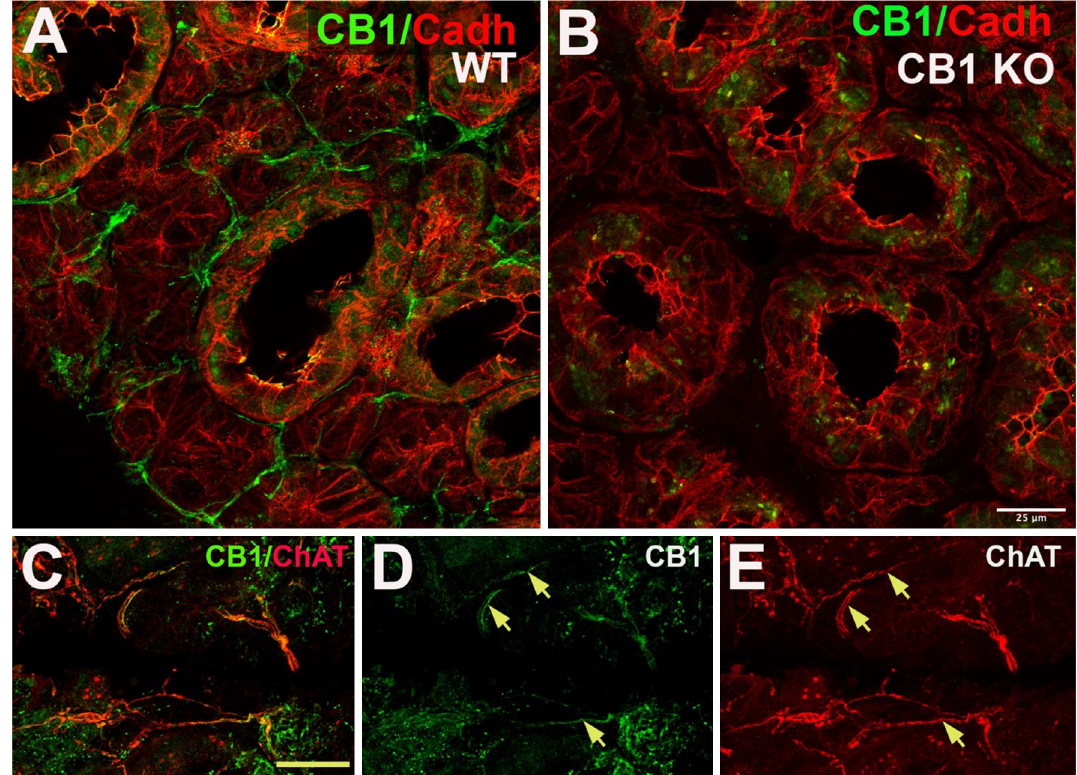
Figure 2. CB1 protein is expressed in a subset of cholinergic axons in submandibular gland. ( A , B ) Left panel shows CB1 (green) and cadherin (red) in wild type (WT) mouse submandibular gland. Right panel shows that CB1 staining in axon-like processes is absent submandibular gland from CB1 knockout mouse. ( C ) Double staining in submandibular gland of the mouse shows expression of CB1 (green) and choline acetyl transferase (ChAT, red), a marker for cholinergic axonal inputs. ( D , E ) CB1 (green) staining is seen in processes of ChAT- positive axons (arrows). Scale bar: ( A , B ) 25 µm; ( C – E ) 40 µm. Images processed using Adobe Photoshop vsn. 21.2 and FIJI (vsn 2.3.0/1.53q, available at https:// imagej. net/ Fiji/ downl to WT controls. Figure 3A, Control salivation volume (mm on phenol red thread ± SEM): 13.3 ± 0.7, n = 13; THC-treated: 4.7 ± 1.1, n = 11; ***p < 0.01, 1-way ANOVA with Dunnett’s post hoc vs. WT control), consistent with the reduced salivation seen in cannabis-exposed human subjects. Similarly, the potent CB1 receptor agonist CP55940 (0.5 mg/kg) also lowered saliva volume in WT (Fig. 3A; CP55940 (mm ± SEM): 6.9 ± 1.6, n = 13; 1-way ANOVA (F(4,58) = 11.0, p < 0.0001); Dunnett’s post hoc vs. WT control, **p < 0.01 for CP55940; ***p < 0.005 for THC, NS for SR141716). This was reversed by cotreatment with the CB1 receptor antagonist SR141716 (4 mg/ kg) (Fig. 3A, SR141716/THC (mm ± SEM): 12.5 ± 0.7, n = 7, NS, as above). SR141716 did not alter salivation in male wild type mice on its own (Fig. 3A, SR141716 (mm ± SEM): 12.5 ± 1.5, n = 11, NS, as above). The effect of CP55940 on salivation in males lasts at least six hours (Fig. 3G). Treatment of CB1 knockout mice with THC did not alter basal salivation (Fig. 3B, CB1 KO control (mm ± SEM): 12.4 ± 1.1, n = 9; THC in CB1KO: 13.6 ± 1.8 n = 9; NS, p < 0.60, unpaired t-test vs. CB1 KO untreated control). Because CP55940 is a non-selective agonist for CB1/CB2 receptors we also tested whether the CB2 agonist JWH133 (4 mg/kg, IP) altered salivation, finding that it did not (data not shown, males (mm ± SEM): 12.6 ± 0.8, n = 8; females: 13.5 ± 1.3, n = 11; NS, p = 0.55 for males, p = 0.71 for females, unpaired t-test vs control). In female mice treatment with THC or CP55940 also reduced saliva levels (Fig. 3C, WT saliva volume (mm ± SEM): 12.8 ± 1.1, n = 14; THC-treated: 6.5 ± 1.0, n = 13; CP-treated: 8.0 ± 1.0, n = 15; 1-way ANOVA (F(4,67) = 10.4, p < 0.0001); Dunnett’s post hoc vs. WT control, **p < 0.01 for CP55940; ***p < 0.005 for THC, NS for SR141716). As in males, the effect of THC was blocked by the CB1 receptor antagonist SR141716 (Fig. 3C, SR141716/THC (mm ± SEM): 11.9 ± 0.5, n = 8, NS, as above) and SR141716 did not alter salivation in females on its own (Fig. 3C, SR141716 in WT females: 11.9 ± 1.0, n = 15, NS as above). Treatment of the female CB1 knockout mice with THC did not alter basal salivation (Fig. 3D, CB1 KO control (mm ± SEM): 18.6 ± 1.3, n = 8; THC in CB1 KO: 17.7 ± 1.2, n = 8; NS, unpaired t-test vs. KO control, p = 0.60). CBD does not alter salivation but reverses THC effects in a concentration‑dependent man‑ ner. In separate experiments, treatment with the phytocannabinoid cannabidiol (CBD, 4 mg/kg IP) did not alter salivation in males or females [Fig. 3E, CBD in males (mm ± SEM): 12.8 ± 1.1, n = 12; CBD in females: 11.2 ± 1.1, n = 12; NS, unpaired t-test vs. respective WT control, p = 0.65 (males), p = 0.34 (females)]. We and